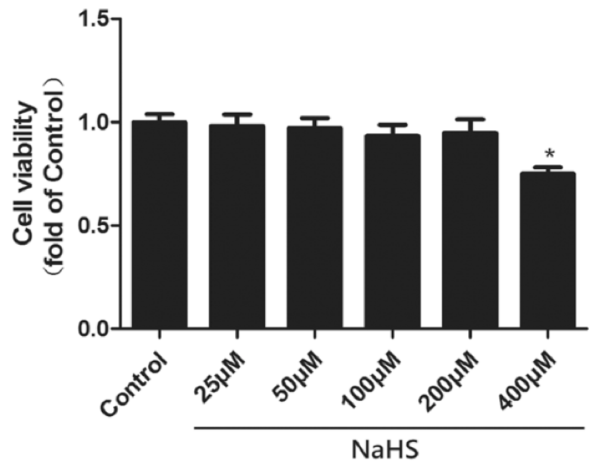
Figure A1. Effect of NaHS treatment on the viability of HepG2 cells. After 12 h of serum starvation, HepG2 cells were treated with the indicated concentrations of NaHS for another 24 h. Cell viability was detected by WST-8 based colorimetric assay. Data were expressed as mean ± SEM. The results are representative of three independent experiments ( n = 3). * p < 0.05 vs. control.